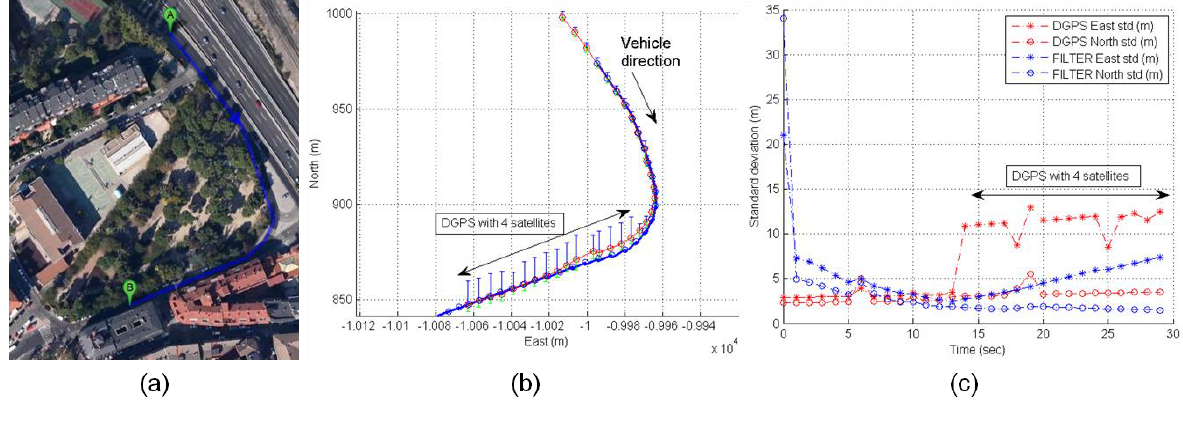
Figure 22. ( a ) Rover trajectory within complex urban canyon. ( b ) DGPS and GPS solutions (red) and UKF filter solution (blue). ( c ) Standard deviations of DGPS and GPS: East (upper blue bar) and North (lower green